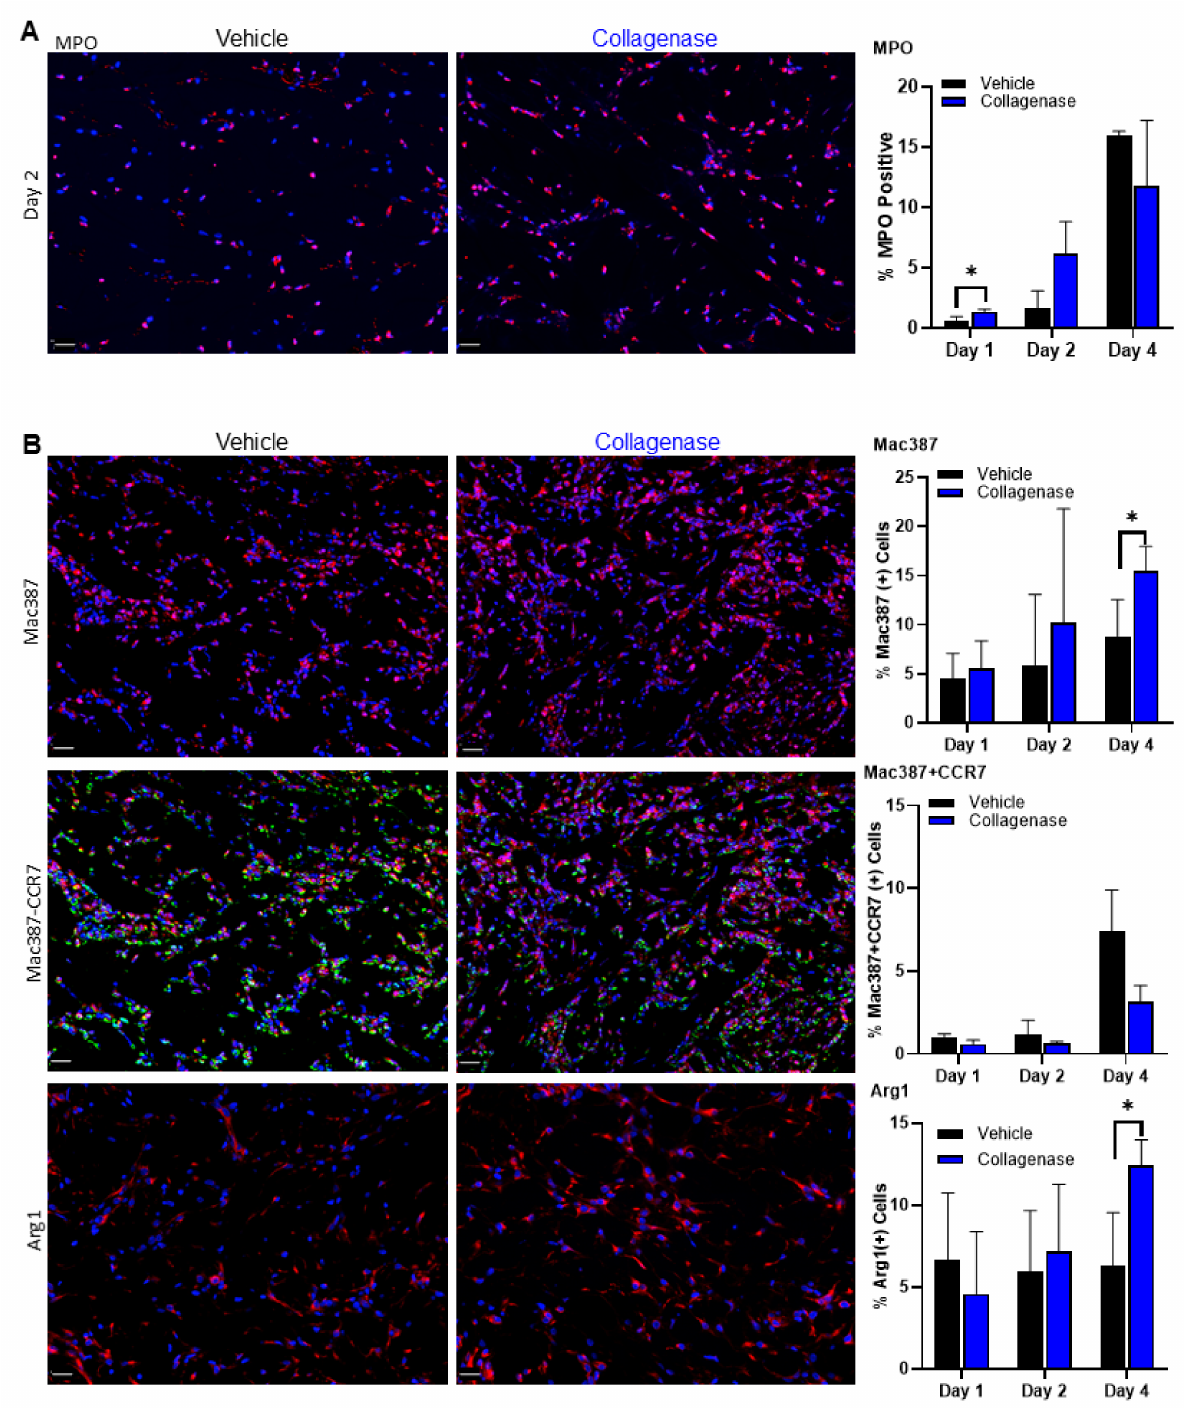
Figure 6. Collagenase-treated burns show early and improved inflammatory response. ( A ) Burn wound interspace sections were immunolabeled with antibodies against myeloperoxidase (MPO), an Alexa Fluor 555-labeled neutrophil marker. Early induction of neutrophils in collagenase-treated burns was observed 1 and 2 days post-burn. The number of neutrophils was counted for each tissue cross-section and %MPO-positive cells was calculated from the total number of positive stained MPO cells/total cells × 100%. ( B ) Immunolabeled monocytes and macrophages in the wound interspace sections on day 4 for vehicle and collagenase treatments. Top panel: the number of macrophages was labeled for each tissue cross-section with Alexa Fluor 555-labeled macrophage marker Mac387 and %Mac387-positive cells was calculated from the total number of positive stained Mac387 cells/total cells × 100%. Middle panel: the M1 macrophage phenotype was